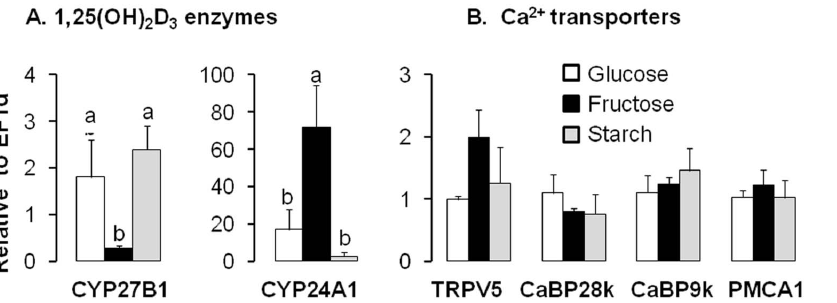
Figure 4. Expression of 1,25(OH) 2 D 3 metabolizing enzymes and of Ca 2 + transporters in the kidney of mice fed for three mo a high fructose, starch, or glucose diet containing normal Ca 2 + levels. (A) Marked effects of excessive fructose intake on mRNA expression levels of renal 1,25(OH) 2 D 3 metabolic enzymes, CYP27B1 and CYP24A1. (B) mRNA expression levels of renal TRPV6, CaBP28k, CaBP9k and PMCA1. All expression data were analyzed by real-time PCR using EF1 a as a reference and normalized relative to levels seen in mice fed glucose diet. Data are means 6 SEM ( n =5 per group). Differences ( P , 0.05) among means are indicated by differences in superscript letters, as analyzed by 1-way ANOVA LSD. Thus, within a gene of interest, bars with superscript ‘‘a’’ are . bars with ‘‘b’’. Chronic consumption of high fructose levels has dramatic effects on mRNA expression of renal 1,25(OH) 2 D 3 metabolizing enzymes but not on Ca 2 + transporter mRNA expression.